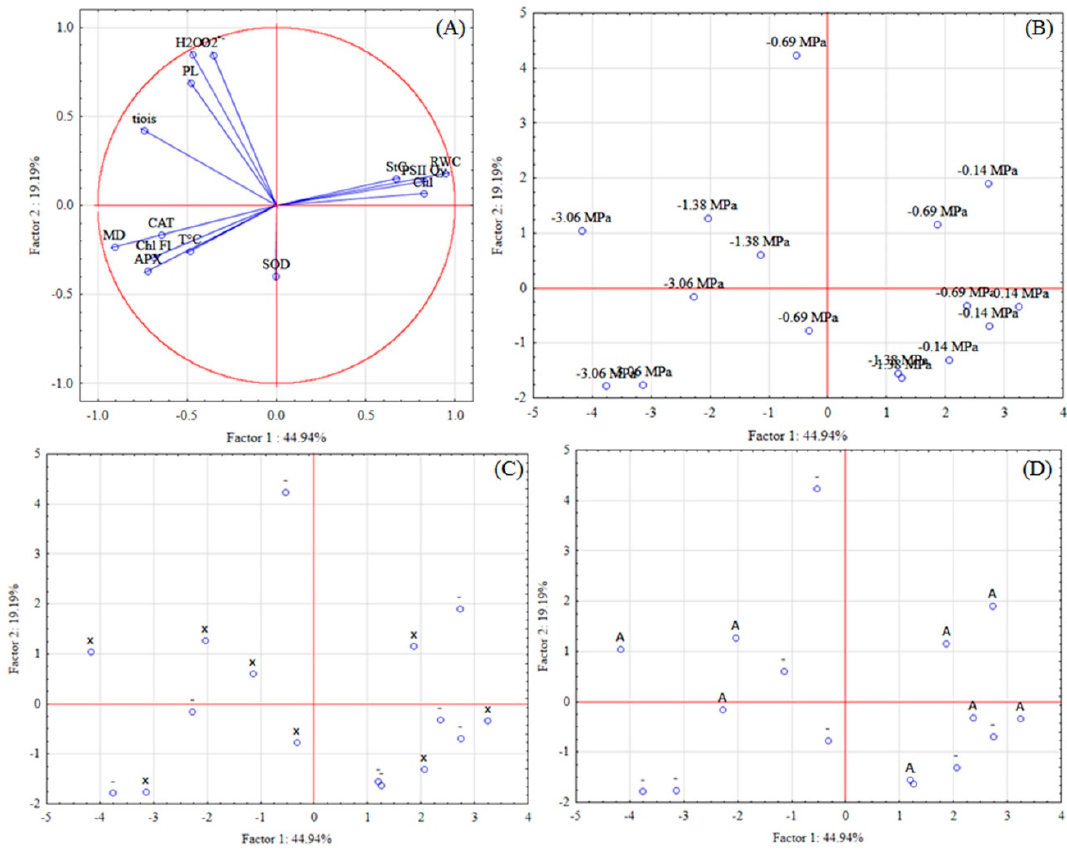
Figure 8. Projection of the variables ( A ) and cases—soil water potential ( B ), xenobiotic ( C ), and antioxidant agent ( D ) on the factor-plane of physiological and biochemical variables of soybean plants in experiment II. * Abbreviations—Chl: chlorophyll; StC: stomatal conductance; RWC: relative water content; T°C: leaf temperature; Chl Fl: chlorophyll fluorescence; PSII Qy: photosystem II quantum yield; H 2 O 2 : hydrogen peroxide; O 2• − : superoxide; MD: membrane damage; PL: lipid peroxidation; CAT: catalase; APX: ascorbate peroxidase; SOD: superoxide dismutase; x: xenobiotic, A: antioxidant agent; - without